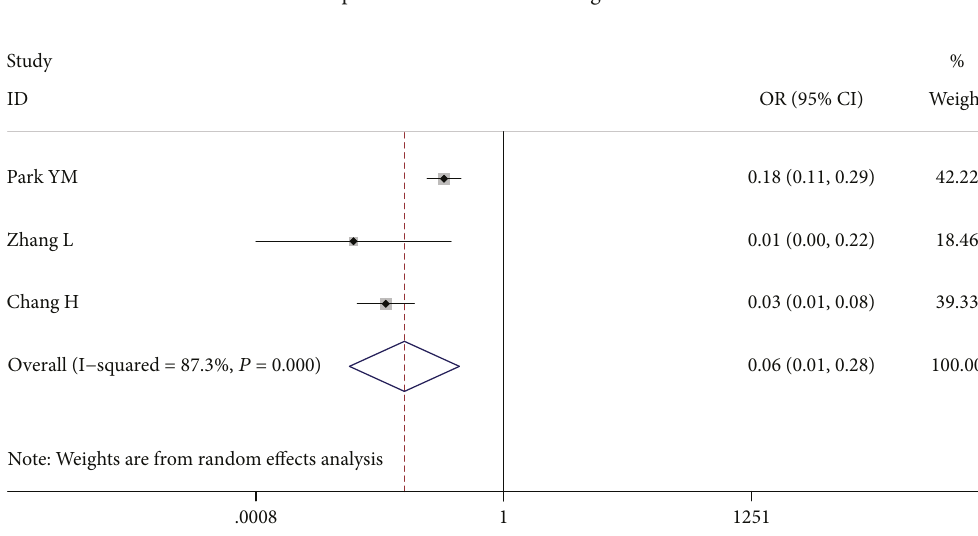
Figure 10: Forest plot for metastasis according to LN-arRLN metastasis.